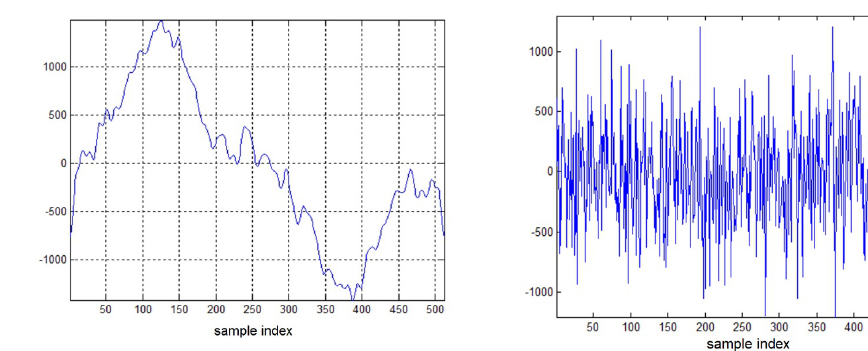
Figure 1. A period from the artificial test signals with constant magnitude.